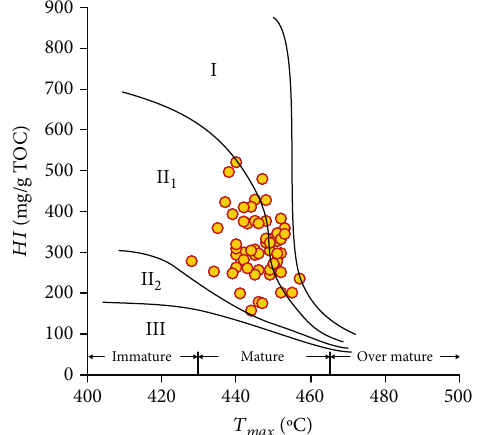
Figure 7: Chart of HI versus the Rock-Eval pyrolysis temperature of the maximum [28] for well DP1 in the western Ordos